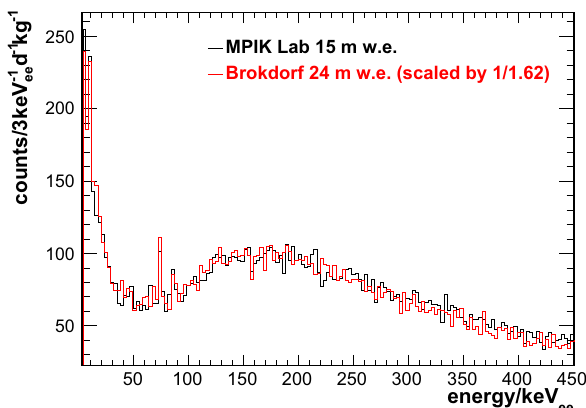
Fig. 7 ComparisonofmeasurementsinsidetheCONUSshieldwithout the active muon veto at the MPIK laboratory and at reactor site. The latter one was scaled with a factor of 1 . 62 − 1